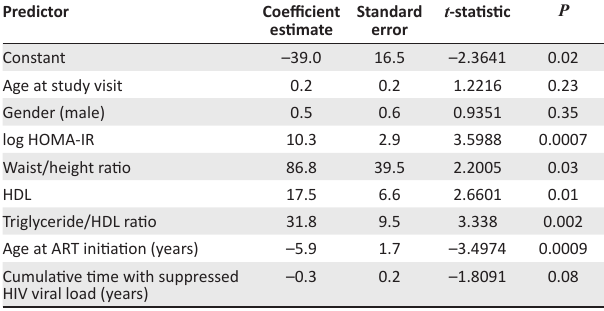
TABLE 4: Multivariable linear regression model with pulse wave velocity z -score as the outcome variable, showing a trend towards association with cumulative time with suppressed HIV.